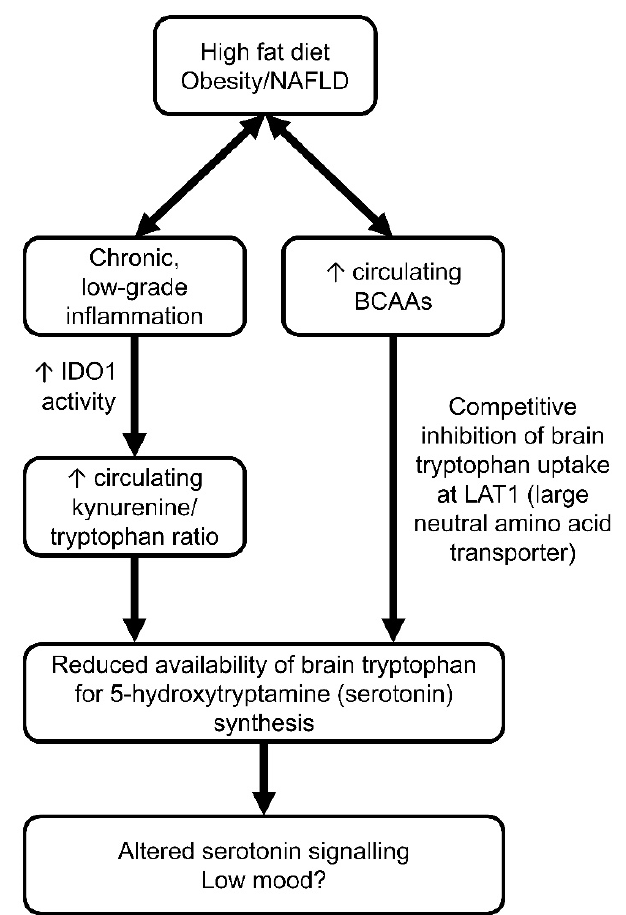
Figure 3. Potential mechanisms describing how diet-induced metabolic syndrome (obesity/NAFLD) may lead to altered brain plasticity and low mood. On the left side of the flowchart, chronic, low- grade inflammation is thought to upregulate peripheral indoleamine 2,3-dioxygenase (IDO1) activity, leading to increased kynurenine production from tryptophan and reduced brain tryptophan uptake for central serotonin synthesis. On the right, elevated circulating branched-chain amino acids may arise after prolonged high-fat diet feeding. BCAAs compete with tryptophan for the large neutral amino acid transporter (LAT1), reducing brain uptake of tryptophan and central serotonin synthesis. This may lead to altered neurotransmission and low mood. ↑ increase.